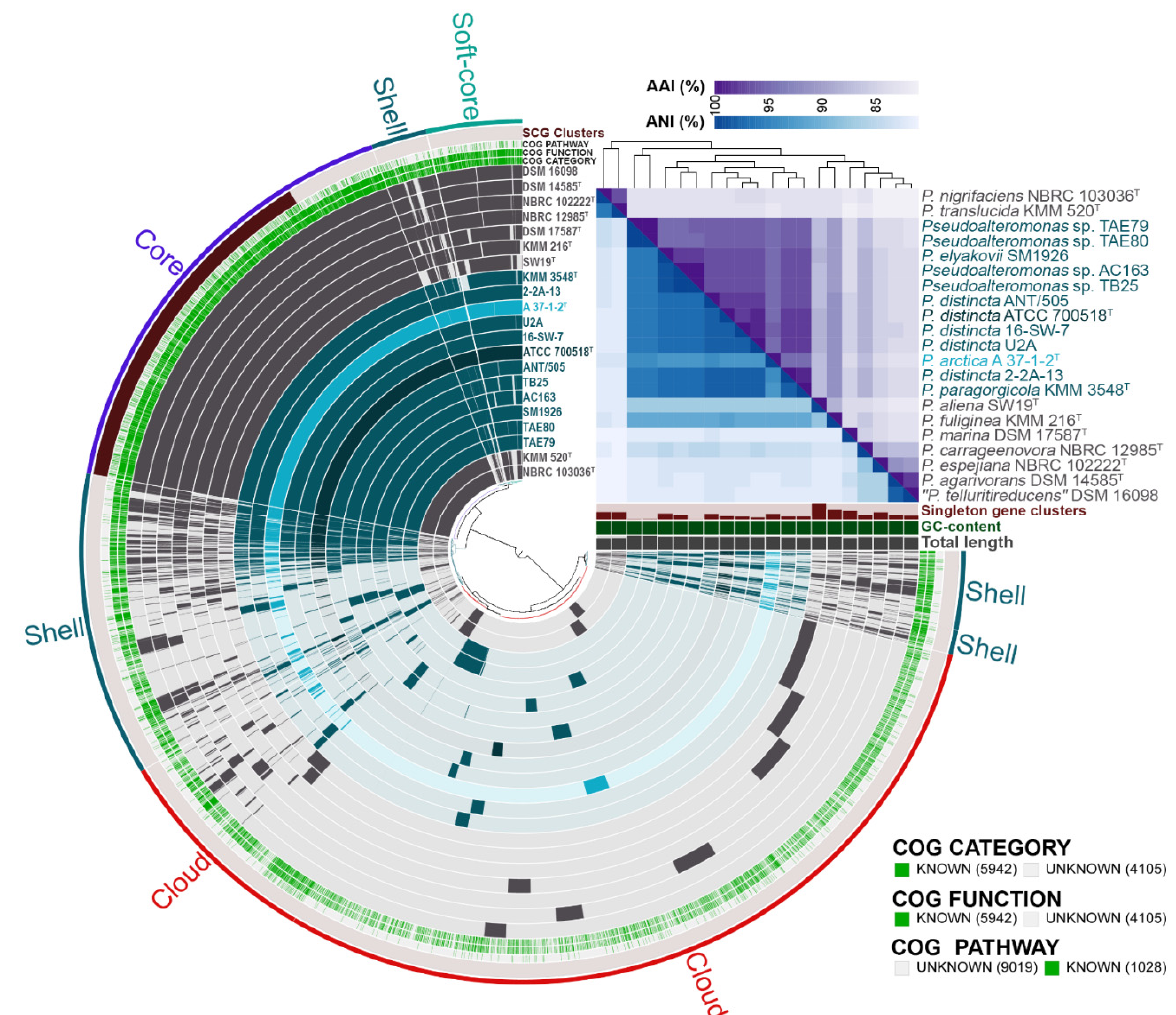
Figure 4. The pan-genome of 21 Pseudoalteromonas strains. Clustering of the genomes based on the presence/absence patterns of 10,045 pan-genomic clusters. The genomes are organized in radial layers as core, soft-core, shell, and cloud gene clusters (Euclidean distance; Ward linkage), which are defined by the gene tree in the center. The genome of the type strain P. distincta ATCC 700518 T is colored very dark blue (hex code #04353d), the genomes of other P. distincta strains are colored sherpa blue (hex code #065563), the genome of P. arctica A 37-1-1 T is colored cyan blue (hex code #10abc7), and the genomes of other Pseudoalteromonas species are colored grey (hex code #4f4a4f). The heatmap displays pairwise values of average nucleotide (ANI) and amino acid (AAI) identities in percentages calculated using the online server ANI/AAI-Matrix.